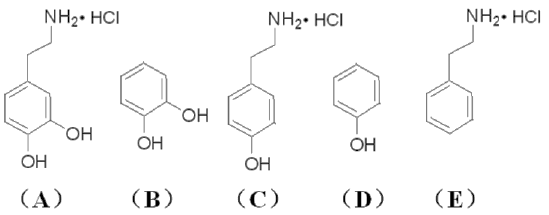
Figure 1. Structural formulas of ( A ) DA hydrochloride, ( B ) CA, ( C ) TA hydrochloride, ( D ) Ph and ( E ) PEA hydrochloride.